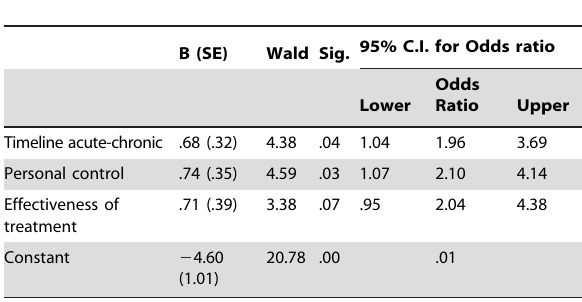
Table 3. Logistic regression analysis (enter method) on pre- hospital delay.